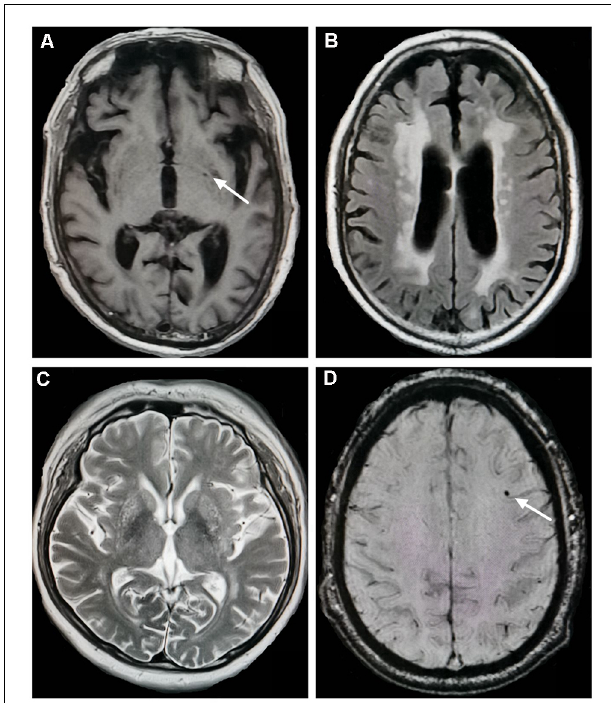
FIGURE 1 | Neuroimaging markers of cerebral small vessel disease. (A) Lacunes (white arrow) in the left basal ganglia (T1-weighted imaging). (B) Severe periventricular white matter hyperintensities (WMH; fluid-attenuated inversion recovery). (C) Enlarged perivascular spaces in the basal ganglia (T2-weighted imaging). (D) Cerebral microbleeds (white arrow) in the left frontal lobe (susceptibility-weighted imaging).